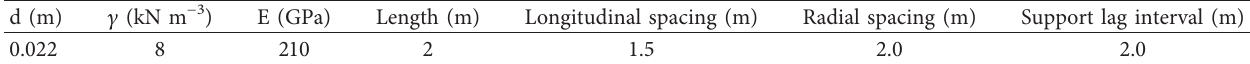
Table 2: Material parameters of anchor.